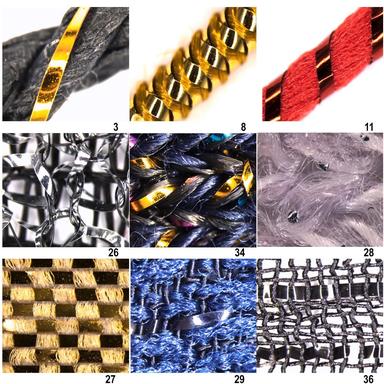
Images of selected samples of cords, cordon, knitted fabrics and woven fabrics in a stereoscopic microscope, at its 40 × microscope magnification.